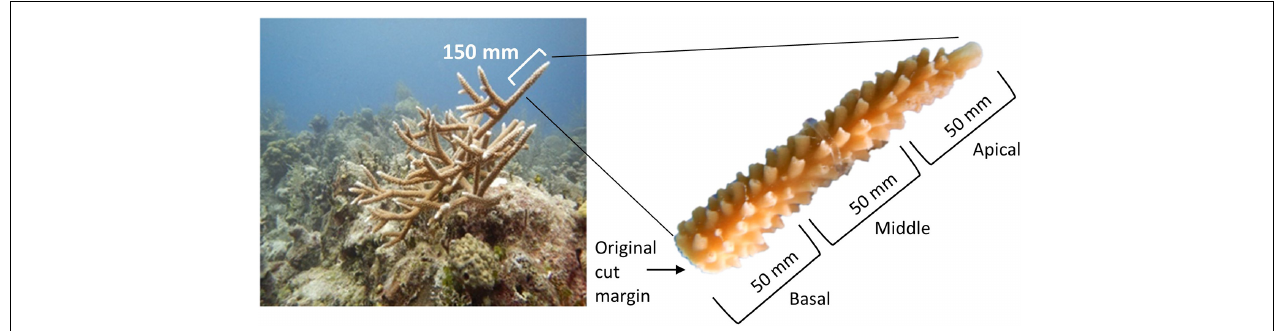
FIGURE 2 | Left : Acropora cervicornis colony showing collection fragment ( ∼ 150 mm). Right : Sections of larger 150 mm fragment. Fragment section was designated from the portion of the donor fragment: the first 50 mm (proximal end) were considered the apical fragment section, the next 50 mm were the middle fragment sections, and the interior most 50 mm of the donor fragment were the basal fragment sections.